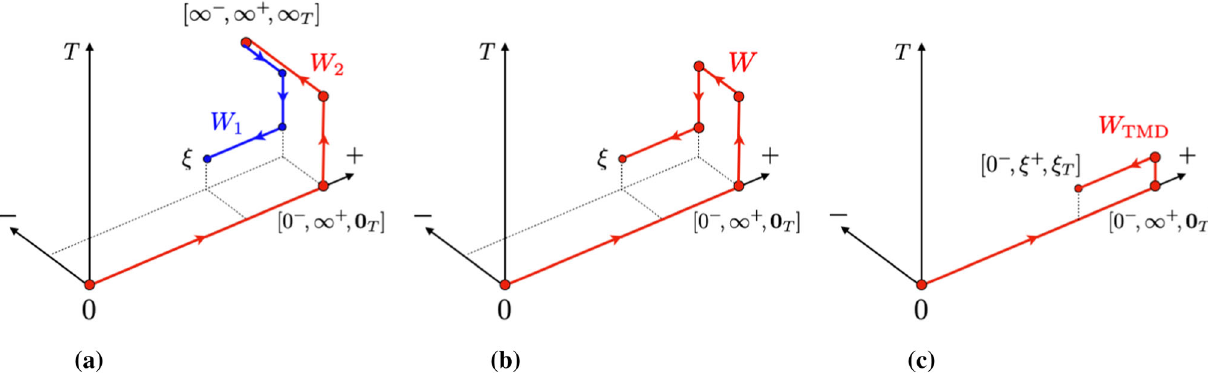
Fig. 2 Staple-like Wilson line paths for the jet correlator (cid:5)( k ; w = n + ) : a W 2 ( 0 , ∞; w = n + ) (red) and W 1 ( ∞ ,ξ ; w = n + ) (blue); b the combined Wilson line W ( 0 ,ξ ; w = n + ) ; c the TMD Wilson line W TMD (ξ + , ξ T